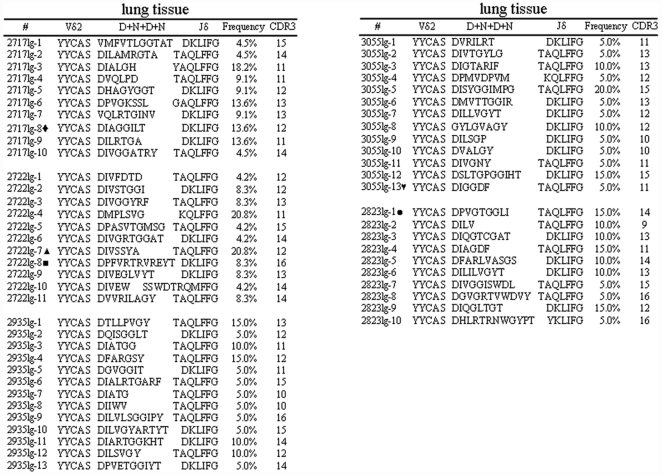
Polyclonally-expanded Vγ2Vδ2 T cells from lymphoid tissues appeared to distribute and localize in lung TB granuloms after Mtb infection by aerosol.Shown are individual Vδ2 TCR clones isolated from lymphocytes of lung tissues from five Mtb-infected macaques. The immunohistochenistry data showing infiltration and distribution of Vγ2Vδ2 T cells in TB granulomas were shown in the previous publication [18]. Flow cytometry data indicating cellular expansion of Vγ2Vδ2 T cells in CD3+ T cells isolated from the lung tissues were described in the text. Note polyclonal Vδ2 TCR sequences and sub-dominant clones in cDNA derived from lung lymphocytes in which expansion of Vγ2Vδ2 T cells was detected. Clones present in blood and spleen were marked as described in the legend of Fig. 1.